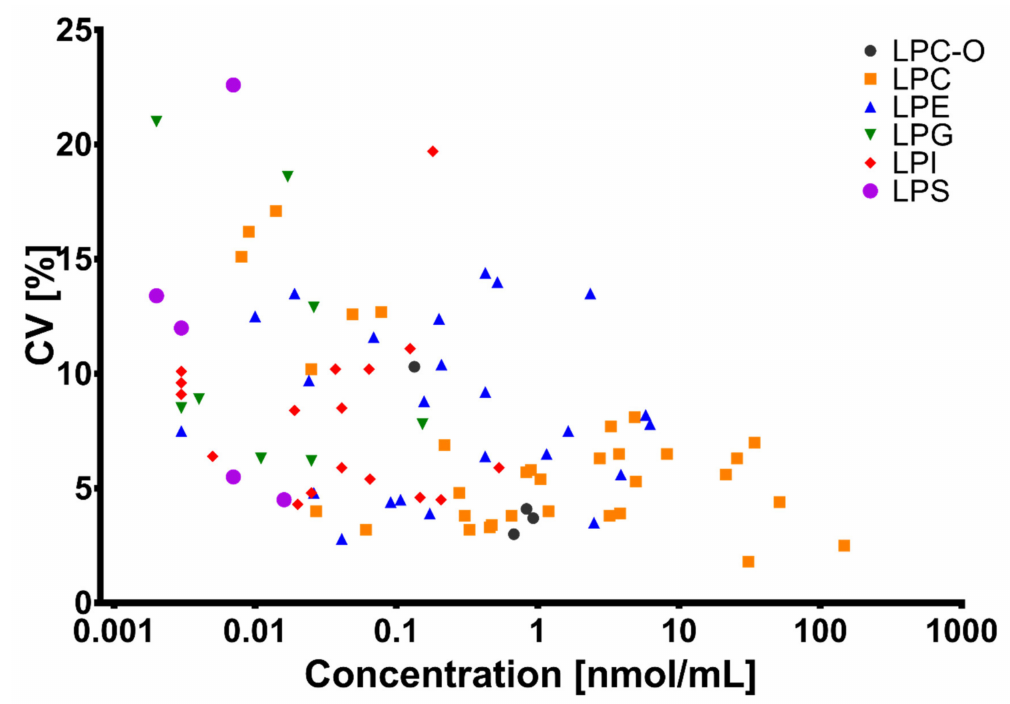
Figure 4. Correlation between the coe ffi cient of variation and average lysophospholipid concentration in a set of 36 plasma samples analyzed on six di ff erent